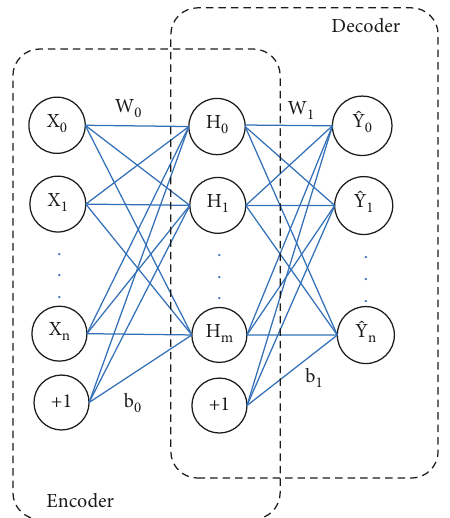
Figure 1: Autoencoder network structure.